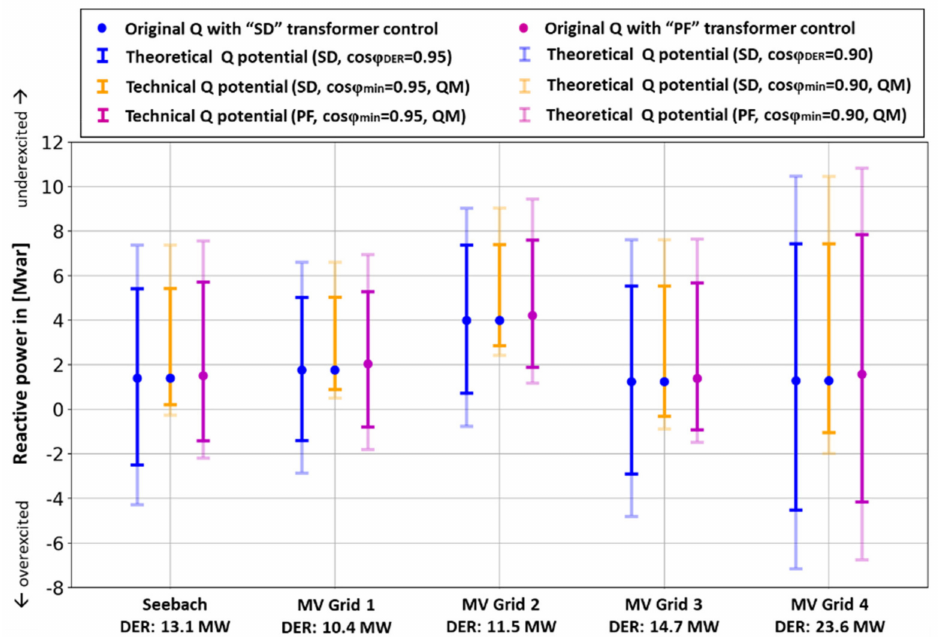
Figure 14. Theoretical (blue) and technical potential with standard transformer control (yellow) as well as with power-flow-dependent transformer control (purple) for five different MV grids of Bayernwerk Netz GmbH (in the case of high DER generation and low load